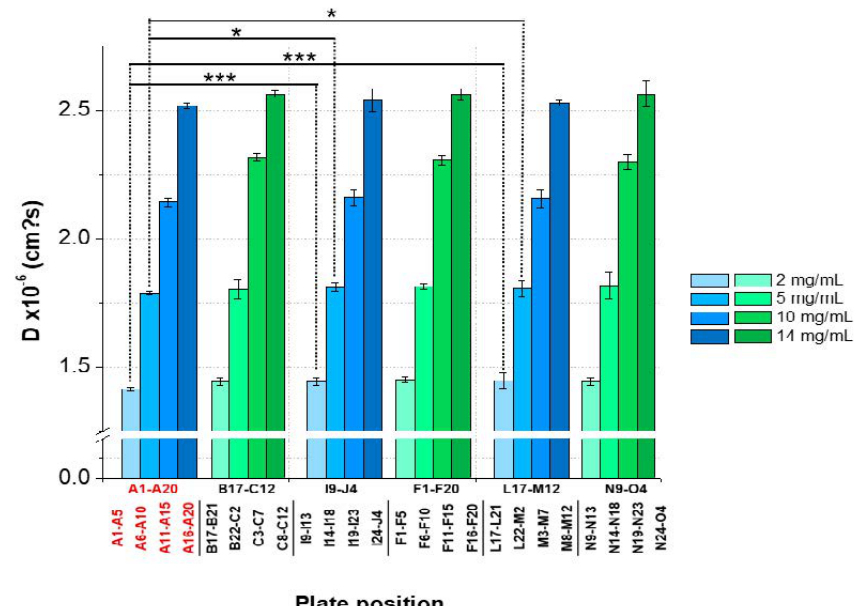
Figure 6. ( A ) Surface tension and dynamic viscosity data as a function of the lysozyme concentration. Red spheres present the surface tension determined by the Wilhelmy plate method, and viscosity data are shown as blue spheres on the secondary y ‐ axis. Error bars represent the standard deviation of 4 measurements. Error bars are possibly smaller than the symbols. ( B ) Diffusion coefficient as a function of the lysozyme concentration and plate position. The red line represents D collected in upper rows, and the black line represents D collected in the bottom rows. Error bars represent the standard deviations of 6 measurements for the diffusion coefficients by DLS.